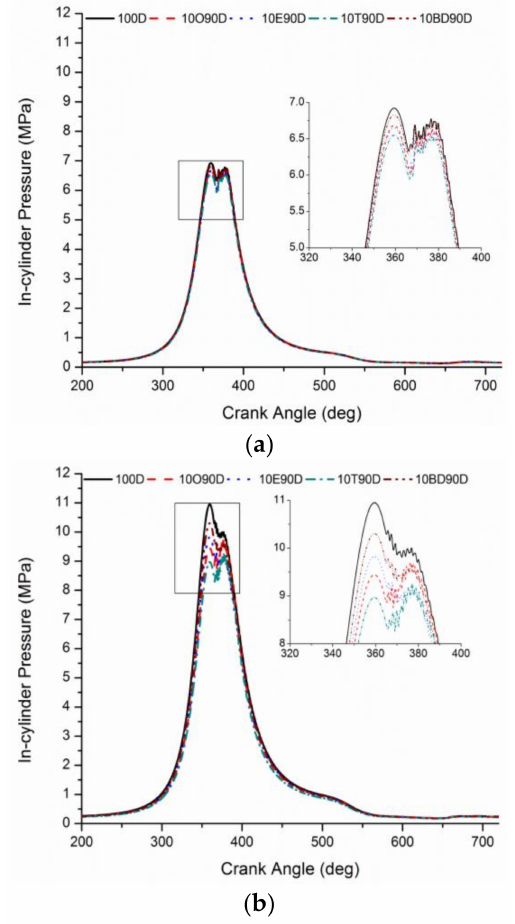
Figure 8. In-cylinder pressure variations of tested fuel blends @ ( a ) 50% and ( b ) 100% load.